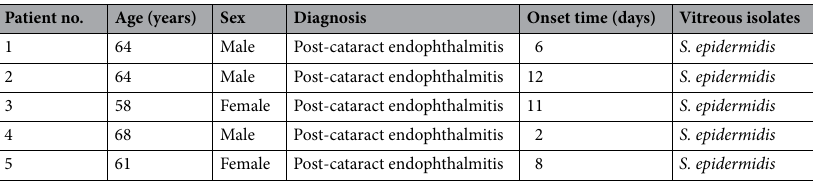
Table 1. Clinical characteristics of all five patients with post-cataract